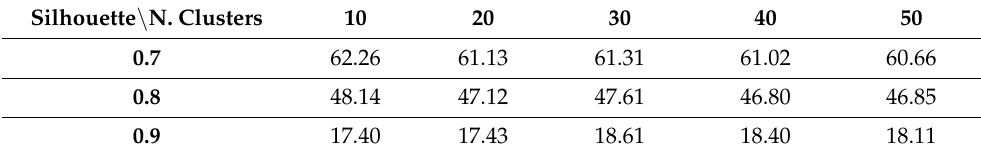
Table 39. Clustering performance in terms of silhouettes using the reduced dataset with SPQR. Silhouette \ N. Clusters